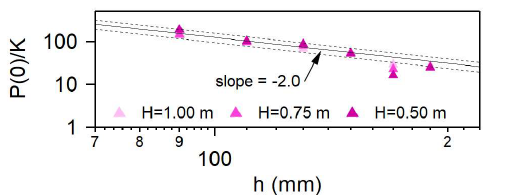
Fig. 5. 𝑷(𝟎)/𝑲 versus 𝒉 for different dropping heights. The continuous line is a power law fit of negative slope (-2); the point-lines defines a ±25% scattering band (72.2% of data falls